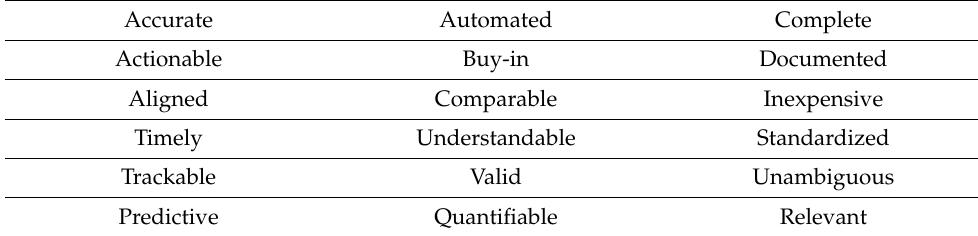
Table 3. Criteria extracted from ISO 22400.